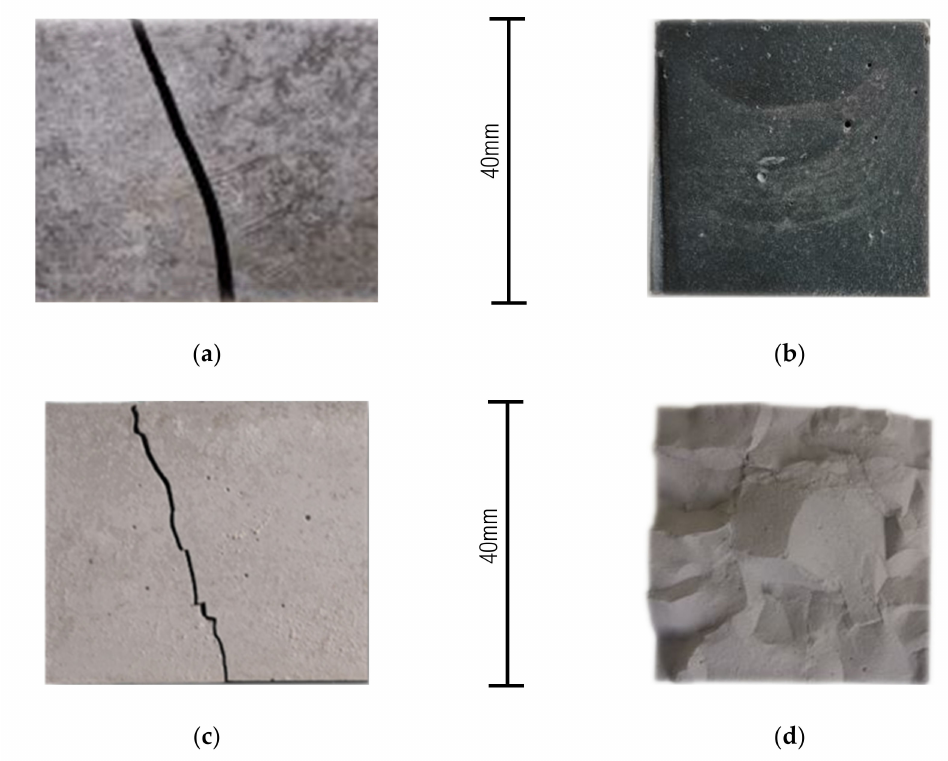
Figure 7. Fracture shape of sample in ( a ) ssd state—curve; ( b ) ssd state—cross-section area; ( c ) oven-dried state—curve; ( d ) oven-dried state—cross-section area.